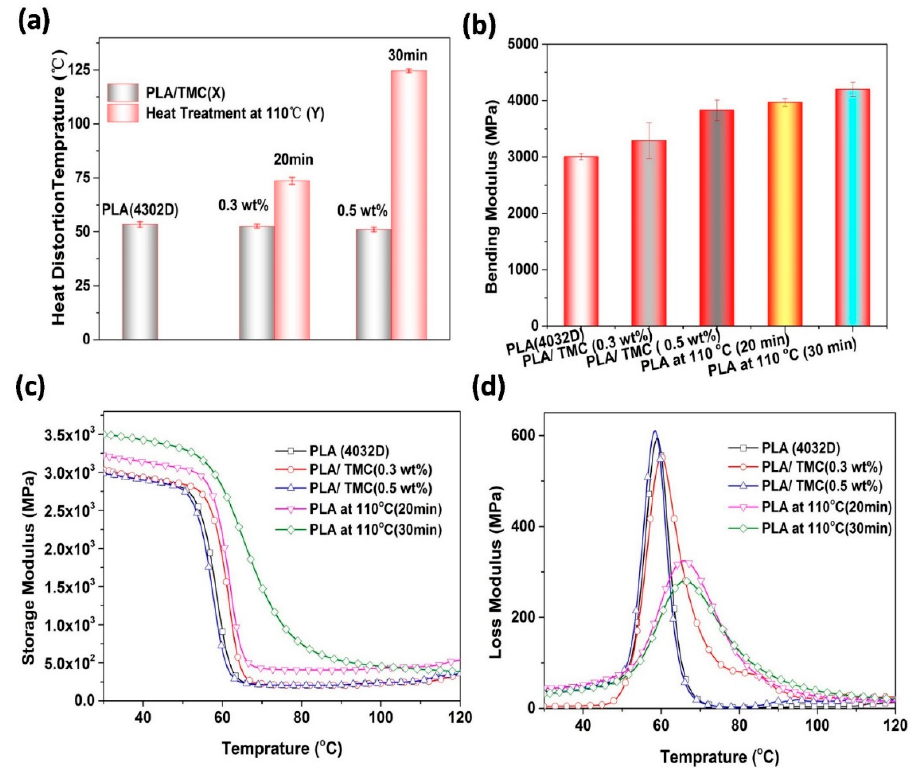
Figure 2. Heat-deflection temperature (HDT) and moduli of samples of neat PLA, PLA / TMC (0.3 wt% and 0.5 wt%) composites and PLA treated at 110 °C under varying heat treatment durations (20 and 30 min): ( a ) HDT, ( b ) bending modulus, ( c ) storage modulus, ( d ) loss modulus.